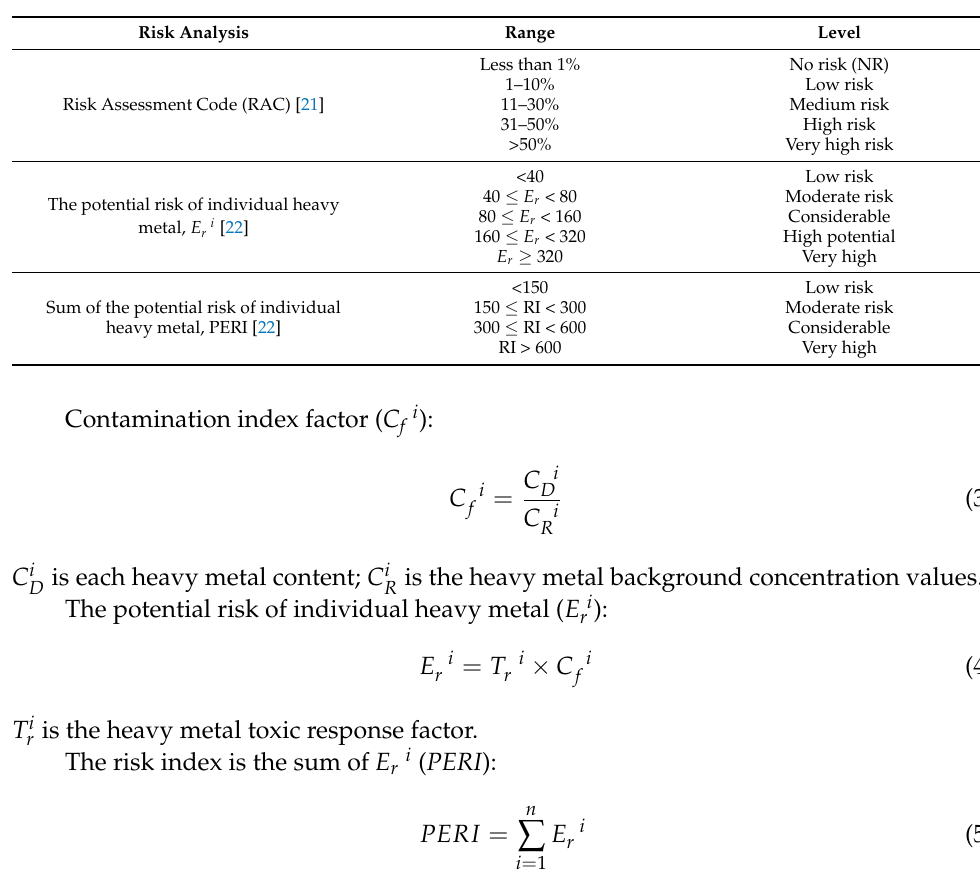
Table 1. Ecological risk level using the PERI method.